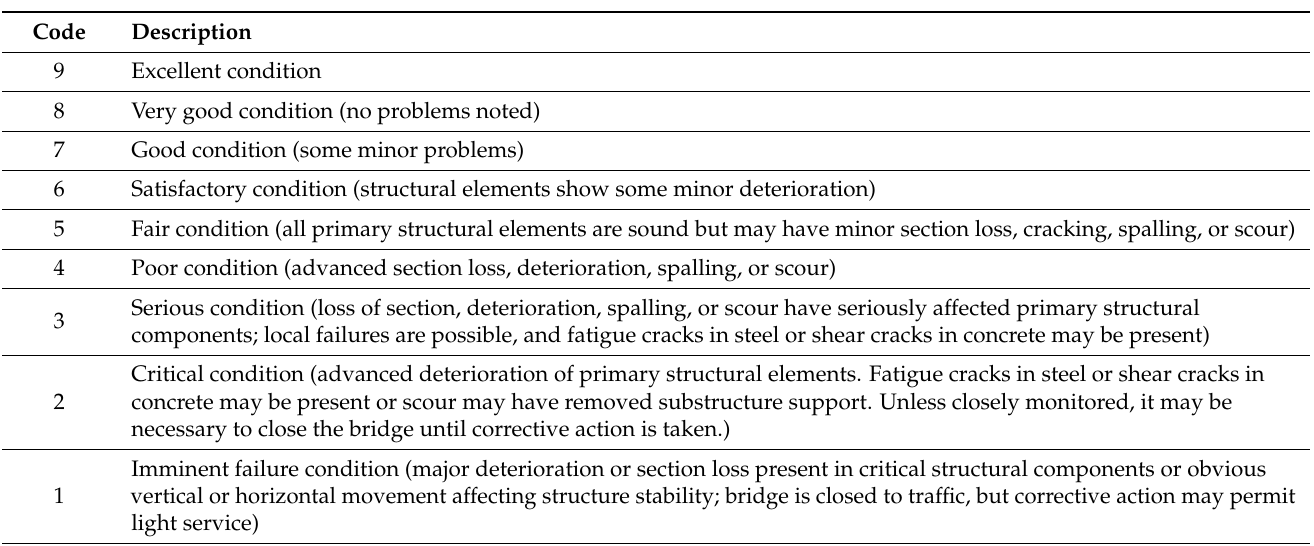
Table 1. FHWA ratings for bridge conditions (FHWA,